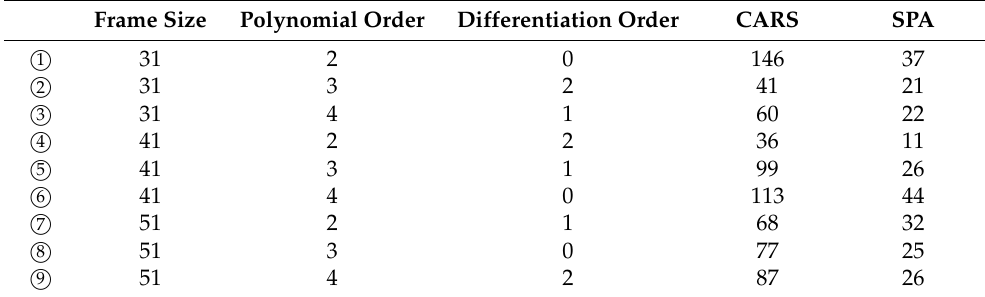
Table 2. Orthogonal experiments of parameter combinations in preprocessing and the corresponding number of characteristic wavelengths obtained using CARS and SPA. Frame Size Polynomial Order Differentiation Order CARS